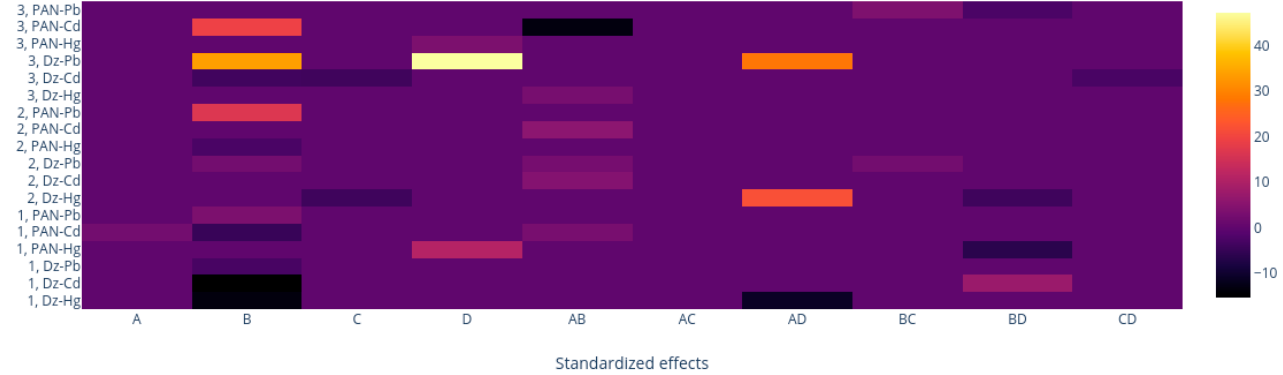
Figure 12. Heatmap of the coefficients of the desirability functions generated by the three different processing methods (M1. M2. M3). A: Time; B: Chromophore. C: Plasticizer; D: CTA.